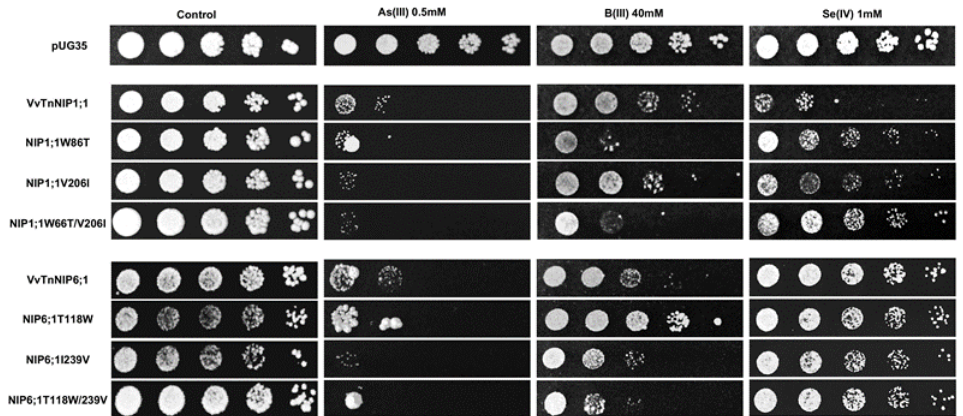
Figure 7. S. cerevisiae aqy-null strain expressing grapevine native NIPs (VvTnNIP1;1 and VvTnNIP6;1), and their ar/R filter mutants. Native strains exhibited sensitivity toward metalloids (As, B, and Se), which was altered by amino acid substitution at H2/H5 residue. Yeast strain transformed with empty plasmid pUG35 plasmid was considered as control. Cells were spotted in 10-fold dilution on plates containing the indicated concentration of test substrates. Minimal media plate without any additional substrate is considered as control. Growth was recorded after one week at 28 °C. Photographs are representative of at least two independent experiments having two replicate plates showing consistent results.